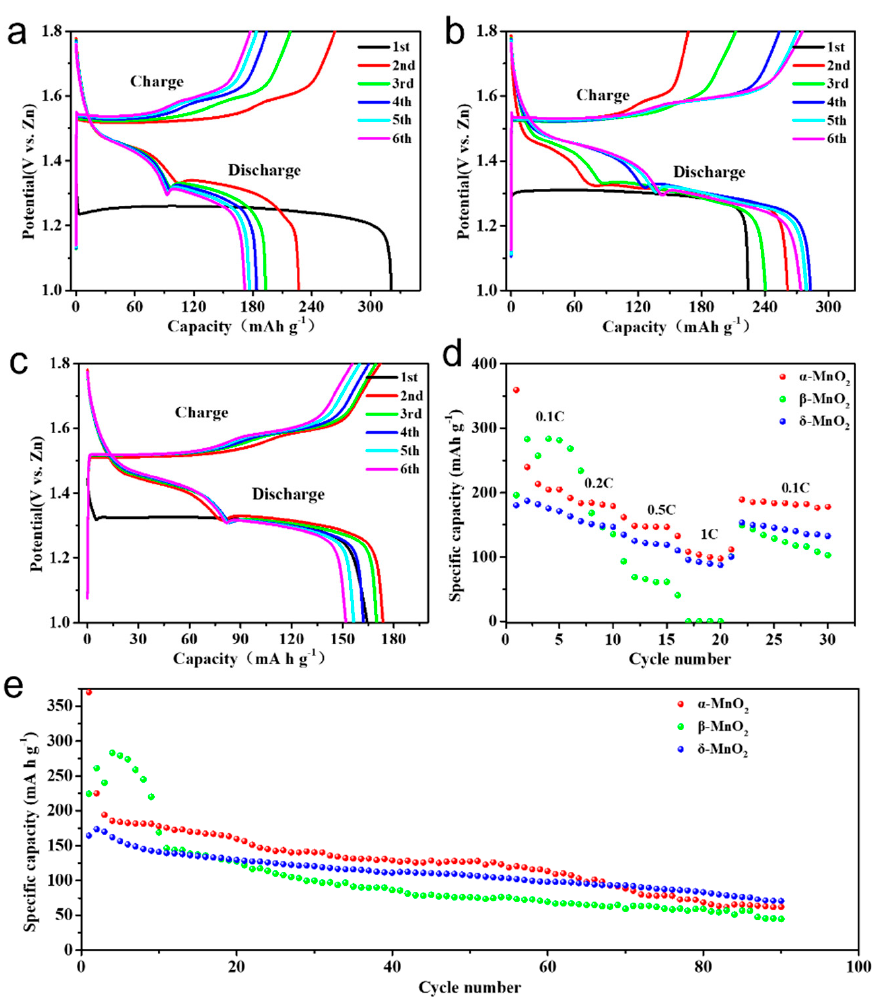
Figure 3. TEM images of ( a – c ) α -MnO 2 , ( d – f ) β -MnO 2 , and ( g – i ) δ -MnO 2 . The galvanostatic charge–discharge (GCD) curves of α -MnO 2 , β -MnO 2 , and δ -MnO 2 were obtained at the rate of 0.2 C (1 C = 300 mA h g − 1 ), and the three MnO 2 with different crystal forms exhibit completely different performances in the initial stage (Figure 4).